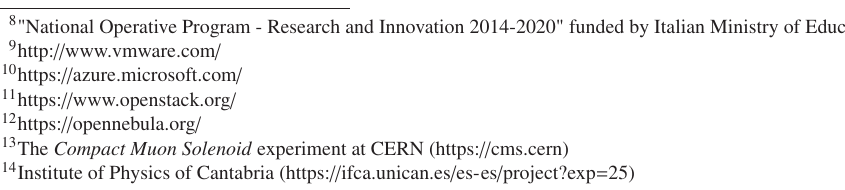
Figure 3. FTE needed per